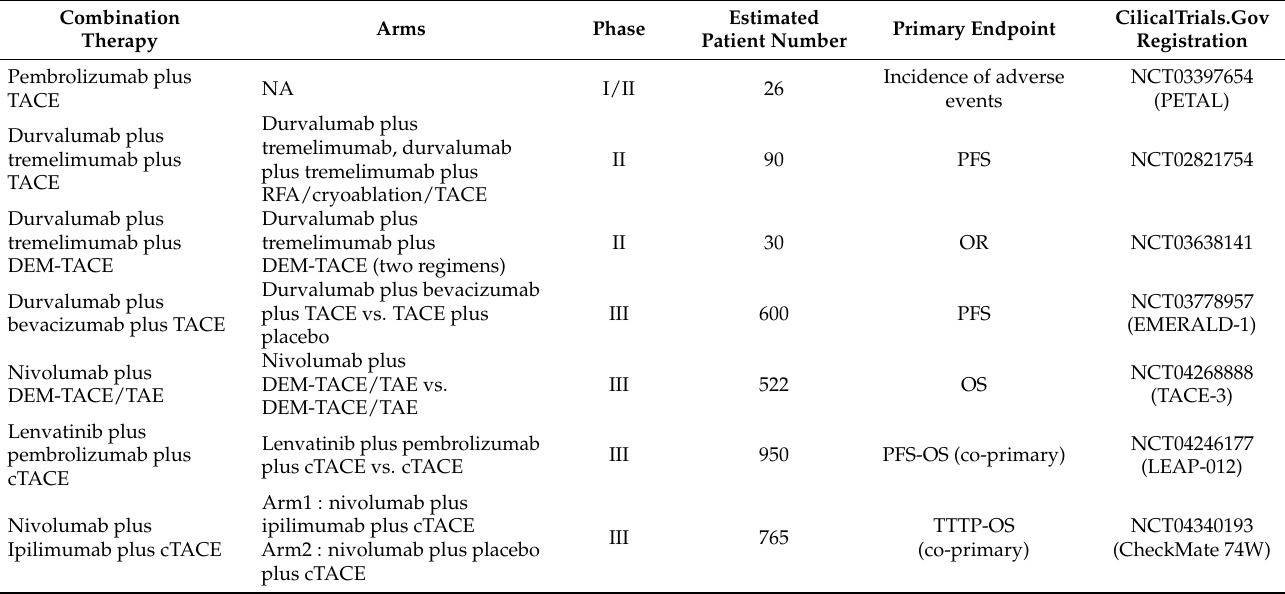
Table 3. Summary of selected trials evaluating combination therapy of immune checkpoint inhibitors or/and tyrosin-kinase inhibitors and